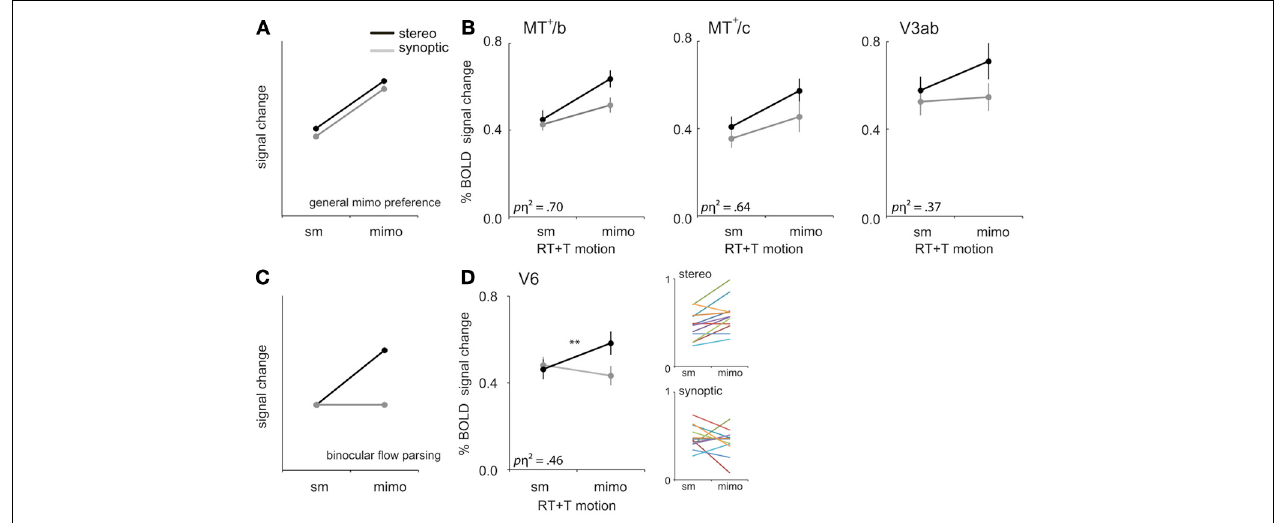
FIGURE 6 | mimo preference. (A) Prediction of the response pattern for a ROI that shows a general preference for multiple independently moving objects (mimo) compared to self-motion (sm) that is not affected by viewmode. (B) Responses of V3ab, MT + /c, and MT + /b to sm and mimo for synoptic and stereo presentation, for RT and T motion combined. (C) Prediction of the response pattern for a ROI that is involved in binocular processing of multiple moving objects.